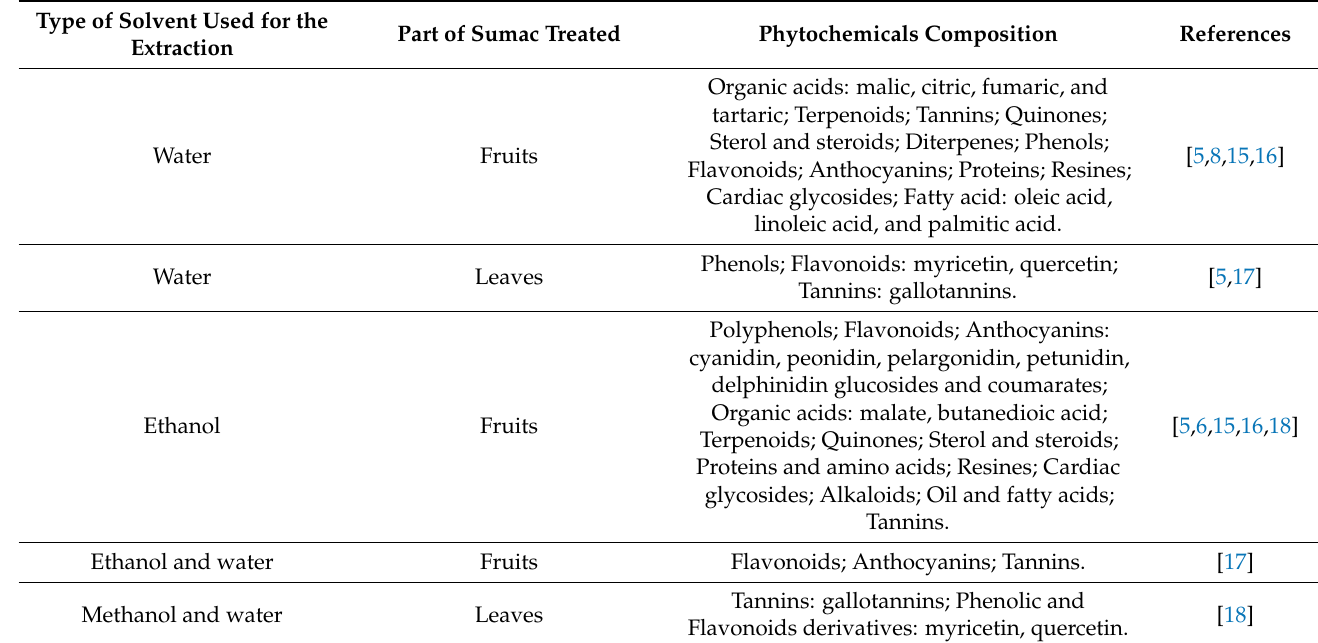
Table 2. Composition of Sumac components based on extraction